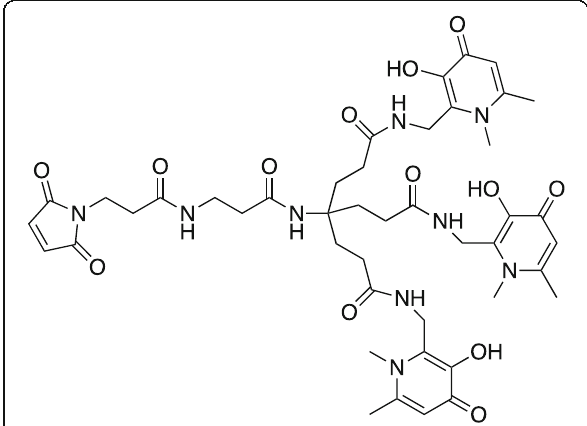
Fig. 1 Chemical structure of the tris(hydroxypyridinone)-maleimide (THP-mal) chelator for